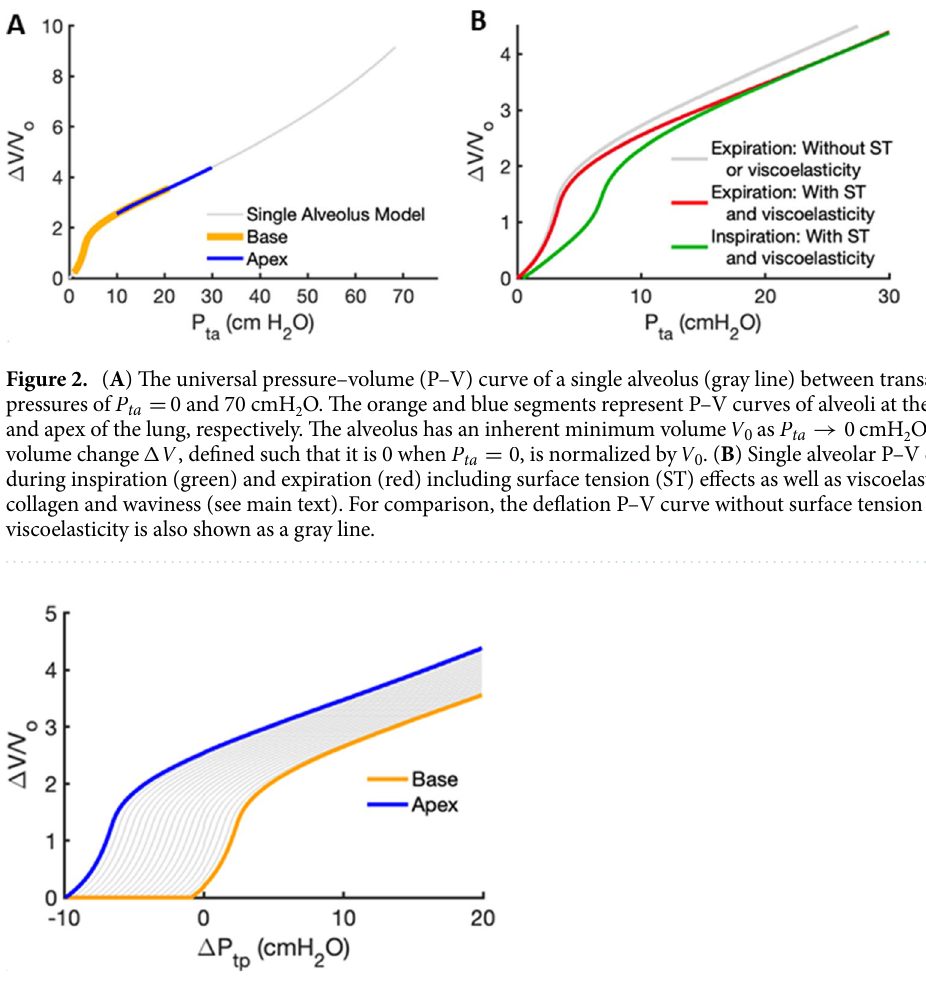
Figure 3. Regional single alveolar P–V curves including the pleural pressure gradient. The P–V curves of the base and apex are shown in orange and blue, respectively, and P–V curves for all other regions by gray lines. The y-axis is the relative volume change as in Fig. 2, whereas the x-axis is given in terms of the common transpulmonary pressure change, (cid:31) P tp , which is 0 when the lung is at FRC. Notice that since the pleural pressure at the base at FRC is − 1 cmH 2 O and hence P ta = 1 cmH 2 O, a (cid:31) P tp = − 1 cmH 2 O creates P ta = 0 for which (cid:31) V =